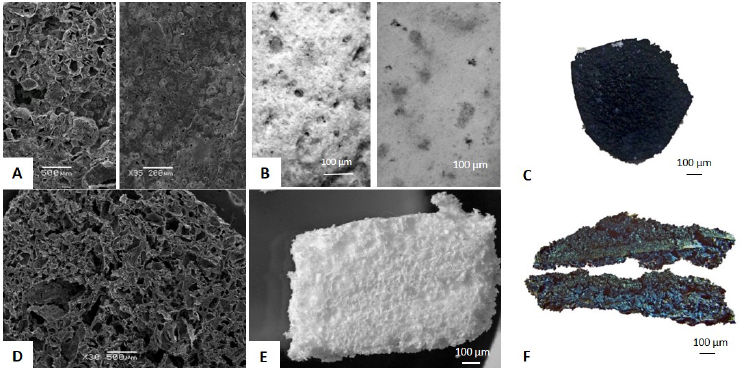
Figure 2. The images of porous PHB scaffolds: ( A , left ) the external side of scaffold-1, SEM, × 30; ( A , right ) the internal side of scaffold-1, SEM, × 35: ( B , left ) the external side of scaffold-1, WLM; ( B , right ) the internal side of scaffold-1, WLM; ( C ) scaffold-1, ink test, WLM; ( D ) scaffold-2, cross- section; SEM, × 30; and ( E ) scaffold-2, cross-section; WLM; ( F ) scaffold-2, ink test,